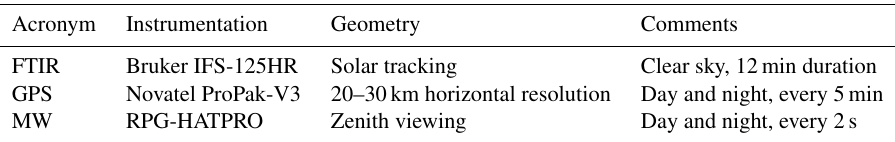
Table 3. Instrumentation for IWV measurements at the St. Petersburg site.